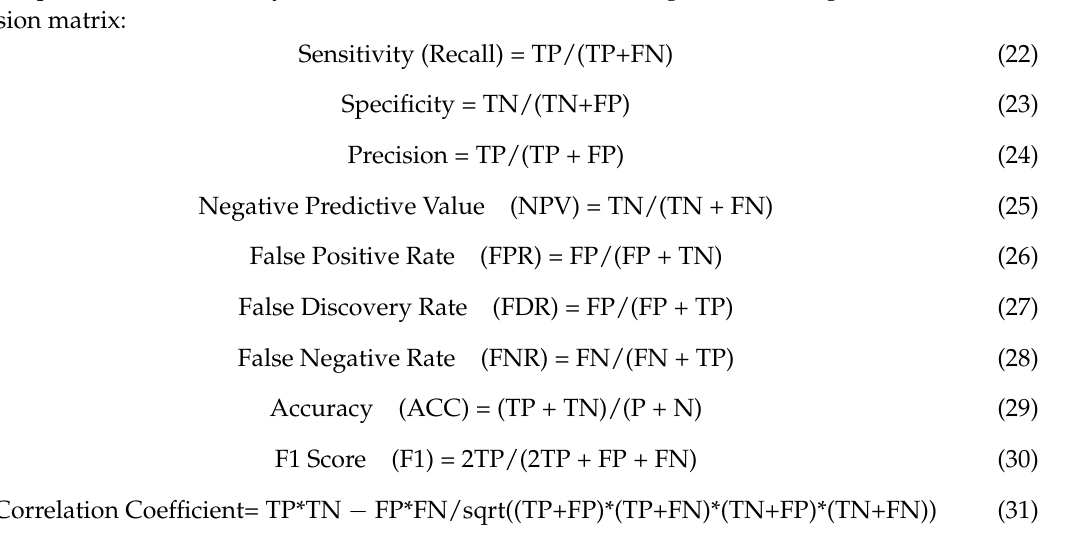
Table 2. Number of sensor activation and activity detection for four different houses equipped with hydrogenous sensing units.